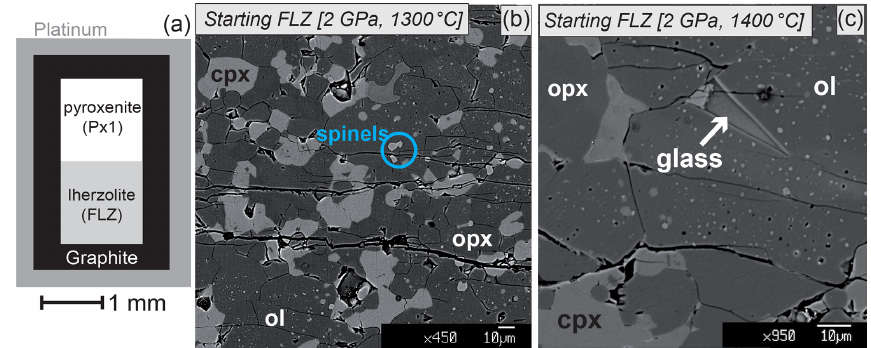
Figure 1. (a) Pyroxenite (Px1) and peridotite (FLZ) reaction couple used as starting material in this study. (b) Back-scattered electron (BSE) image showing the representative texture of subsolidus FLZ at 2GPa and 1300 ◦ C. (c) BSE image of FLZ at 2GPa and 1400 ◦ C consisting of olivine, orthopyroxene, clinopyroxene and rare thin interstitial glass. Table 1. Composition of starting peridotite and pyroxenite investigated in this study and partial melt (Pmelt) derived from Px1 at 2GPa and 1300–1450 ◦ C from Borghini and Fumagalli